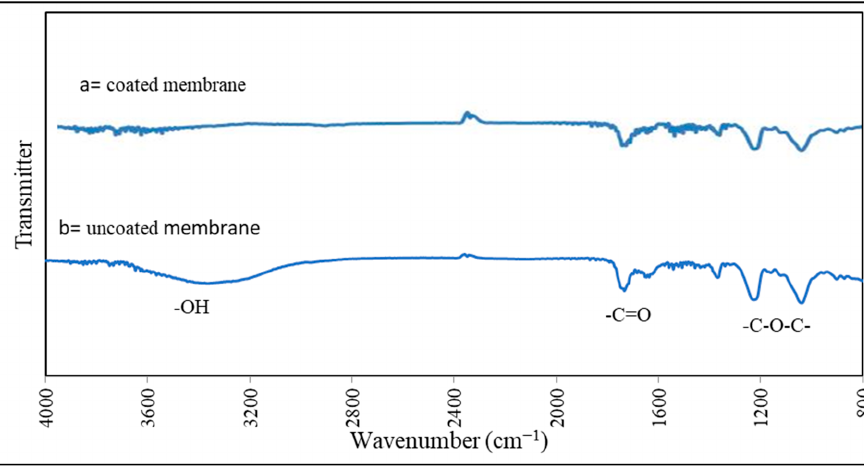
Figure 6. Flow rate comparison of FO system shown as moving average 10 data points.